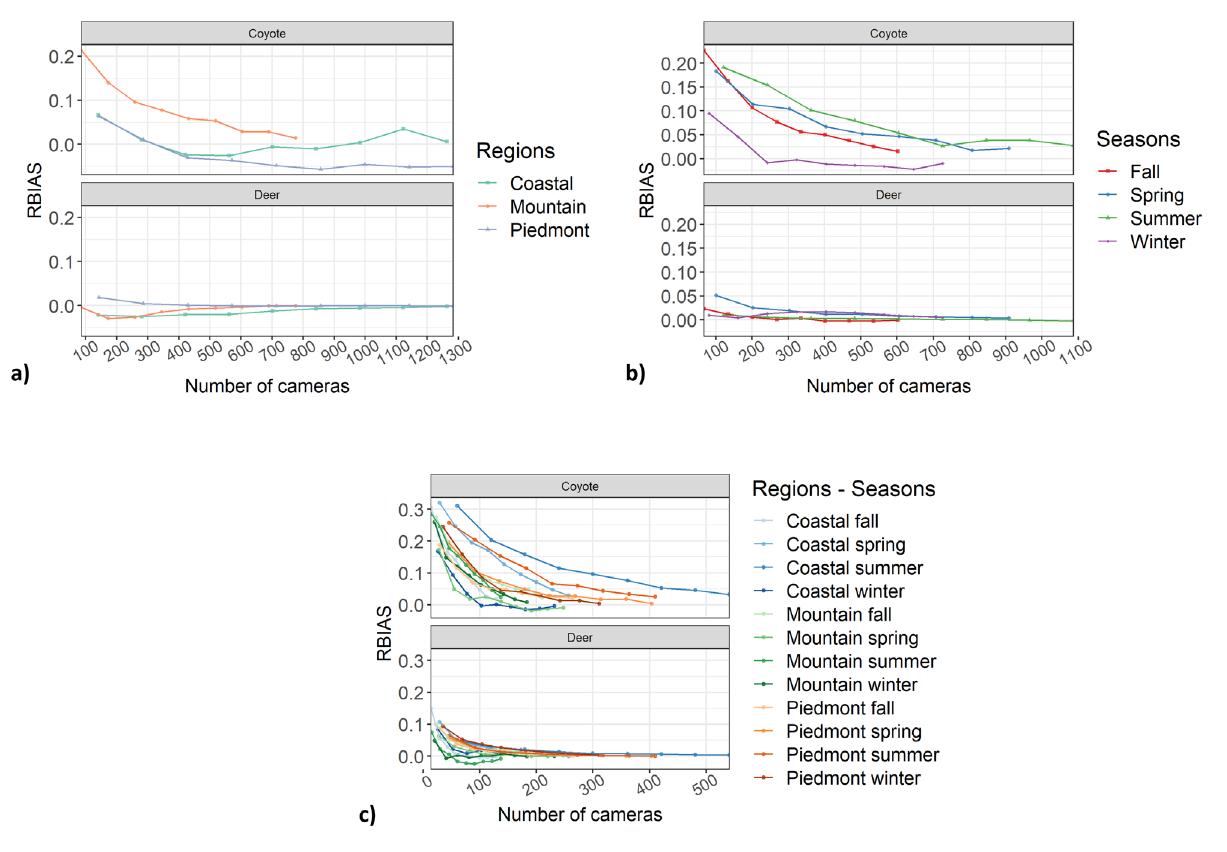
Figure 3 Graphs showing relative bias (a measure how different the estimates were from the full data set estimate) of occupancy estimates for white-tailed deer and coyote. These were calculated with subsets of the full NCCC dataset for a) three ecoregions, b) four seasons, and c) ecoregion-seasons. Our estimates reached our goal for bias (<0.1) at very small sample sizes for the common deer and after sampling 250–300 sites for the less common coyote across all spatio-temporal divisions. The lack of change in these estimates with increasing sample size also indicates a stable, robust result. Results were similar for estimates of error (Supplemental Figure